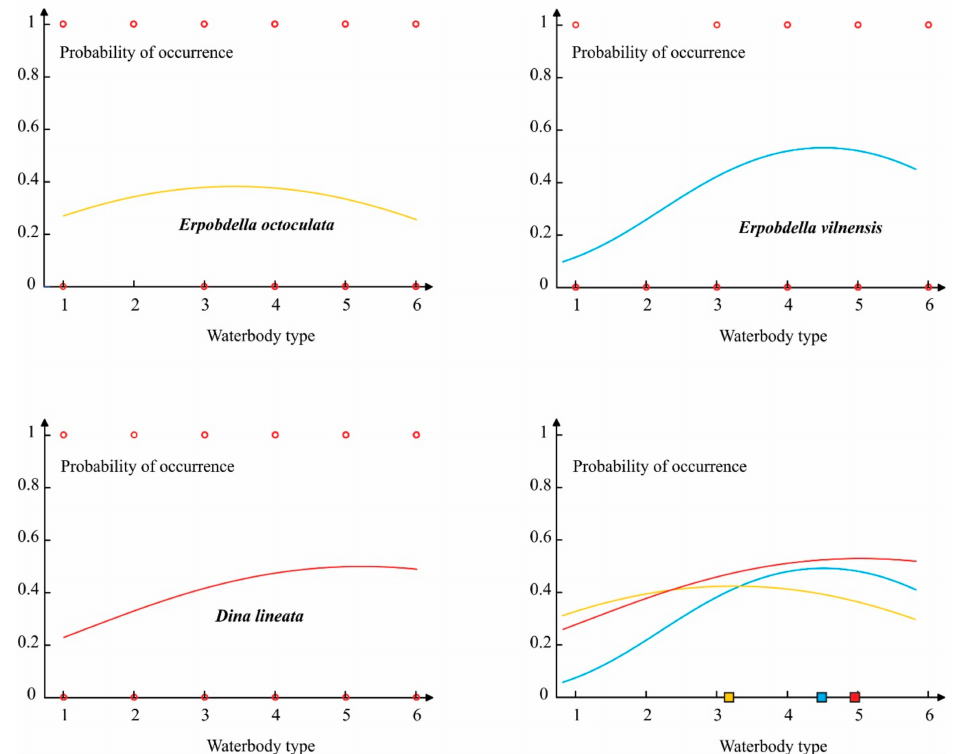
Figure 7. The ecological di ff erentiation of the analyzed species with respect to the waterbody type. Circles denote either the presence (1) or absence (0) of a species at a particular site. Response functions specify the probability of occurrence of taxa along the gradient. Square symbols on the abscissa of the combined diagram represent the optimum value for each